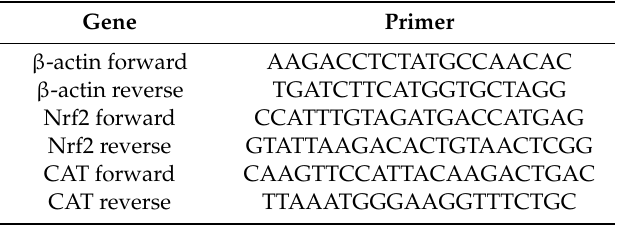
Table 1. List of primers for real-time PCR in H9c2